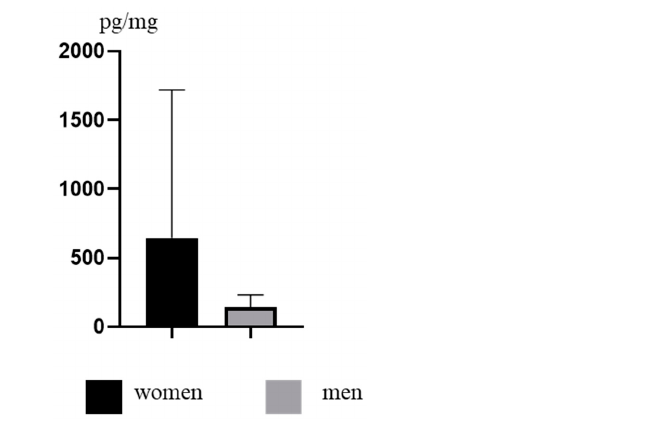
Figure 3. Mean concentration levels (±SD) of TCS in men and women.